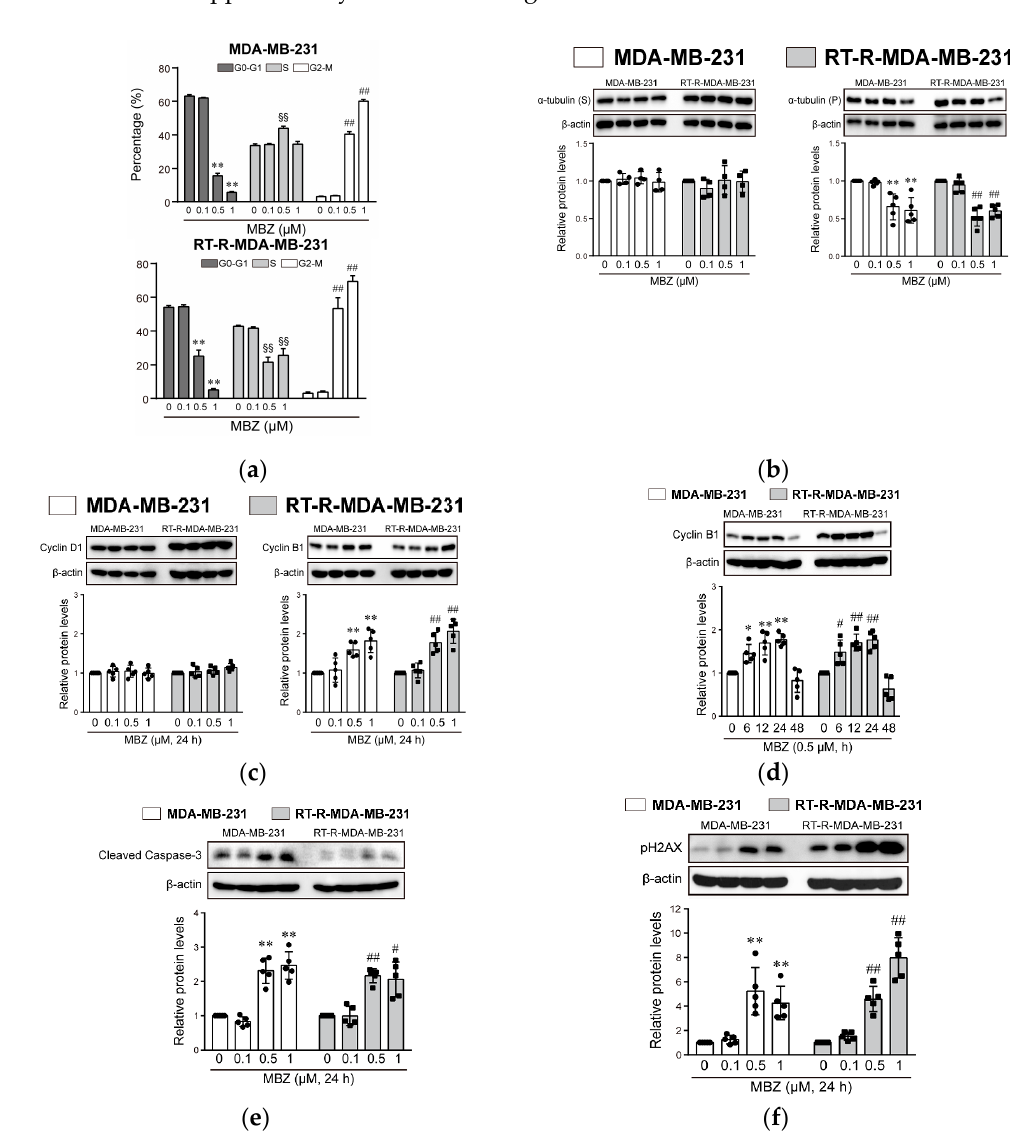
Figure 6. MBZ blocks cell cycle progression of both MDA-MB-231 cells and RT-R-MDA-MB-231 cells in the G2/M phase through inhibiting tubulin polymerization. ( a – c ) MDA-MB-231 and RT-R-MDA-MB-231 cells were treated with MBZ (0.1, 0.5, and 1 μ M) for 24 h, and the ( a ) cell cycle distribution was analyzed quantitatively by flow cytometry analysis. The data represent the mean ± SD of three independent experiments. ** p < 0.01 compared with control in the G0-G1 phase; §§ p < 0.01 compared with control at the S phase; ## p < 0.01 compared with control in the G2/M phase. ( b ) α -tubulin expression and ( c ) cyclin D1 and cyclin B1 expression were analyzed by Western blot. The data represent the mean ± SD of five independent experiments. ** p < 0.01 compared with control of MDA-MB-231 cells; ## p < 0.01 compared with control of RT-R-MDA-MB-231 cells. ( d ) MDA-MB-231 cells and RT-R-MDA-MB-231 cells were treated with MBZ (0.5 μ M) in a time- dependent manner (6, 12, 24, and 48 h), and the cyclin D1 and cyclin B1 expression were determined by Western blotting. The data represent the mean ± SD of five independent experiments. * p < 0.05, ** p < 0.01 compared with control of MDA- MB-231 cells; # p < 0.05, ## p < 0.01 ( e , f ) compared with control of RT-R-MDA-MB-231 cells. ( e ) Cleaved caspase-3 and pH2AX protein levels were examined in the cell lysates of cells treated with MBZ (0.1, 0.5, and 1 μ M) for 24 h. The data represent the mean ± SD of five independent experiments. ** p < 0.01 compared with control of MDA-MB-231 cells; # p < 0.05, ## p < 0.01 compared with control of RT-R-MDA-MB-231 cells. 2.5. MBZ Downregulates the Expression of Cancer Stem Cell (CSC) Markers CD44 and OCT3/4 and Cancer-Progression-Related Protein Endothelial Cell-Specific Molecule-1 (ESM-1) Lastly, we examined the effect of MBZ on CSC markers and the cancer-progression- related protein ESM-1, which was reported in a previous study [15]. CSC markers CD44 and OCT3/4, and ESM-1 were effectively downregulated following incubation with 0.5 and 1 μ M MBZ (Figure 7a–c). There was no difference in the inhibitory effect of 0.5 and 1 μ M MBZ on CD44 and OCT3/4; however, the inhibitory effect on ESM-1 was dose-de- pendent. Densitometry readings/intensity ratio and whole blot for Figure 7 are presented in Supplementary Table S2 and Figure S5. ( a ) ( c ) Figure 7. MBZ reduces the expression of cancer stem cell markers (CD44 and OCT 3/4) and ESM-1, which was enhanced in the RT-R-MDA-MB-231 cells compared to MDA-MB-231 cells. The cells were treated with the indicated concentrations of MBZ (0.1, 0.5, and 1 μ M) for 24 h. The expressions of ( a ) CD44, ( b ) Oct3/4, and ( c ) ESM-1 were determined in cell lysates by Western blotting. Data are expressed as the means ± SD from five independent determinations. ** p < 0.01 compared with control of MDA-MB-231 cells; ## p < 0.01 compared with control of RT-R MDA-MB-231 cells.